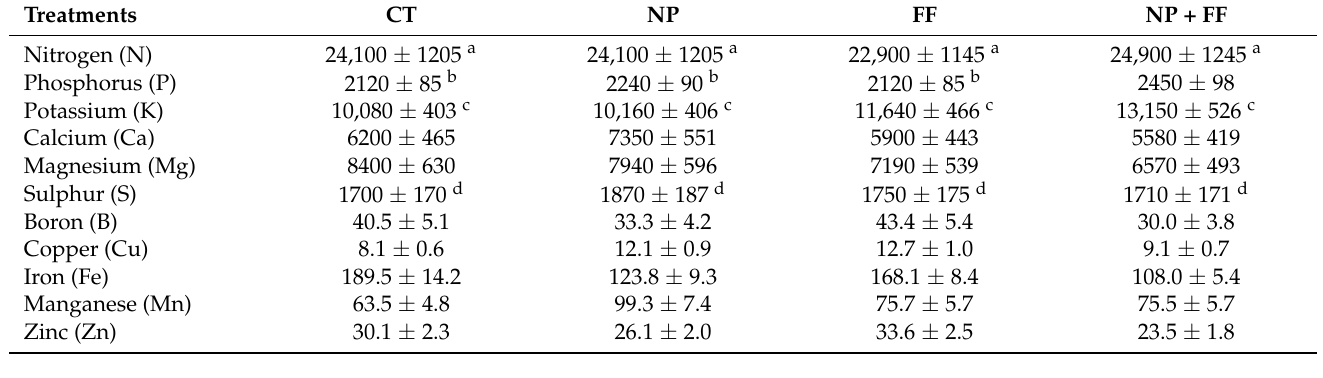
Table 2. The nutrient content of maize leaves due to each treatment. All values in mg kg − 1 of air-dried substance; Different lowercase letters indicate values that are less than the lower critical value of the optimal content: a —28,000 mg kg − 1 [46],